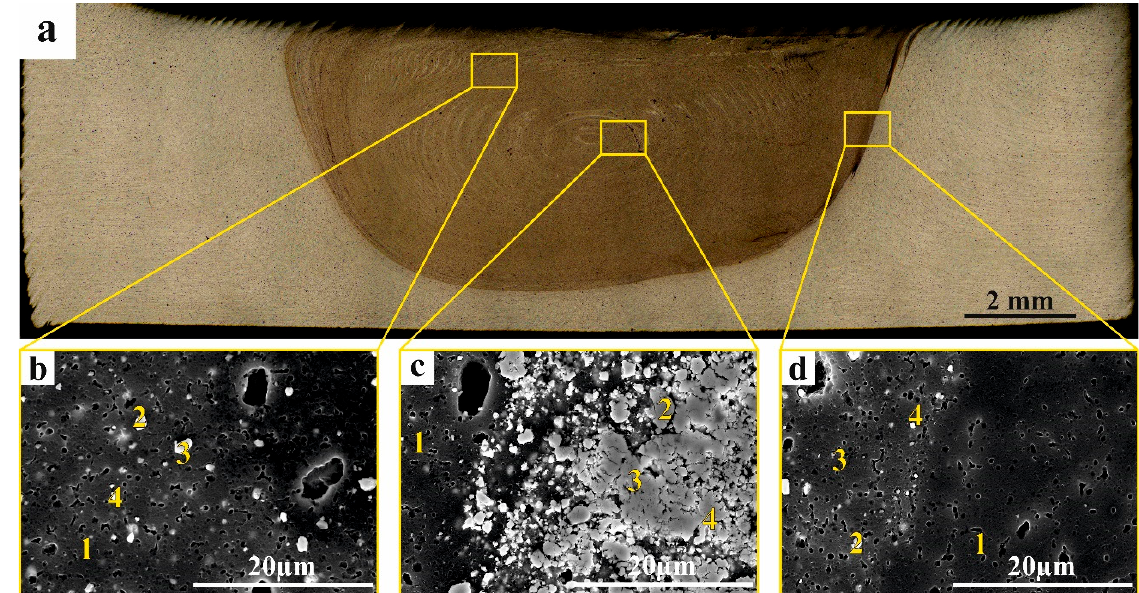
Figure 12. Macro ( a ) and micro ( b – d ) photos of FSP-ed RPPs/AA 5056 composite obtained by SEM: ( a ) macrograph section of FSP-ed RPPs/AA5056 composite after 8 consecutive passes with the tool; ( b ) RPP accumulation zone; ( c ) stir zone; ( d ) thermomechanically affected zone. Numbers on ( b – d ) indicate probe zones for which EDS elemental concentrations were determined indicated in Table 2. Table 2. Chemical composition (EDS) of an etched section of FSP-ed RPPs/AA 5056 after 8 tool passes.